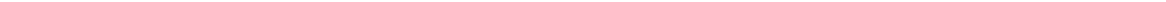
(see fi gure on previous page) Fig. 6 Epigenome is reprogrammed depending on the chromatic positioning of H3.3K36M and H3.1K36M. A The normalized read densities of H3K36me2 at common and unique H3K36me2 peaks in H3.3K36M-mutant cells. A set of shuf fl ed peaks corresponding to the unique peaks was used to analyze whether the enrichment of the ChIP-seq signals was signi fi cant, when compared to background enrichment. *** p < 0.001. B , C The normalized read densities of H3.3K36M ( B ) and H3.1K36M ( C ) at common and unique H3K36me2 peaks in H3.3K36M-mutant cells. A set of shuf fl ed peaks corresponding to the unique peaks was used to analyze whether the enrichment of the ChIP-seq signals was signi fi cant compared to background enrichment. *** p < 0.001. D – F Same as A – C , except the common and unique H3K36me2 peaks in H3.1K36M-mutant cells were analyzed. *** p < 0.001. G The percentages of H3K36M, H3K36me2, and H3K36me3 ChIP-seq peaks in genomic elements. The ChIP-seq results from independent H3.3K36M- and H3.1K36M-mutant clones were pooled. H ChIP-qPCR results of H3K36me2 after the depletion of MMSET and ASH1L in wild-type, H3.3K36M-, and H3.1K36M-mutant cells, respectively. The data are represented by the mean ± SD ( N = 3 independent replicates). I , J Correlations between the changes in H3K27ac and H3K36M at active enhancers in wild-type cells that were within the H3K36me2 peaks in H3.3K36M- ( I ) and H3.1K36M- ( J ) mutant cells. Each dot indicates a single enhancer. R , correlation coef fi cient. The correlations were assessed by Pearson product moment correlation. K , L Correlations between the changes in H3K36me2 and H3K36M at active enhancers in wild-type cells that were within the H3K36me2 peaks in H3.3K36M- ( K ) and H3.1K36M- ( L ) mutant cells. Each dot indicates a single enhancer. R , correlation coef fi cient. The correlations were assessed by Pearson product moment